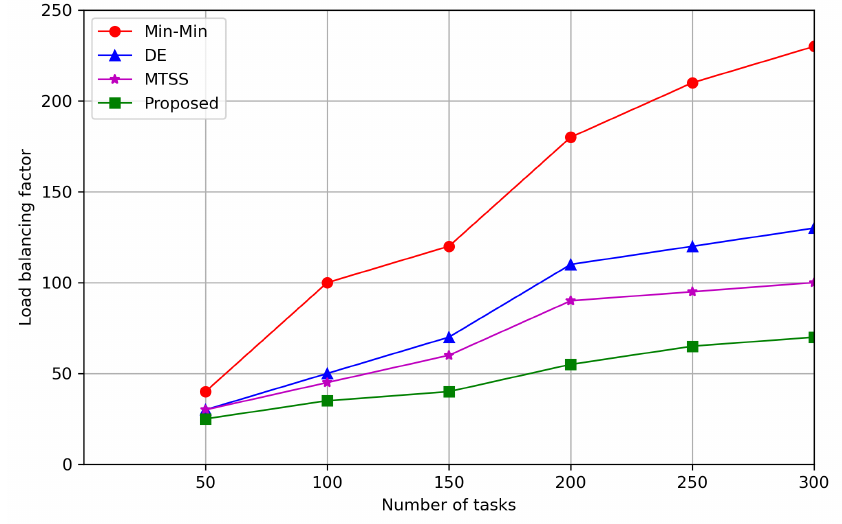
Figure 18. Performance evaluation by using load balancing with number of